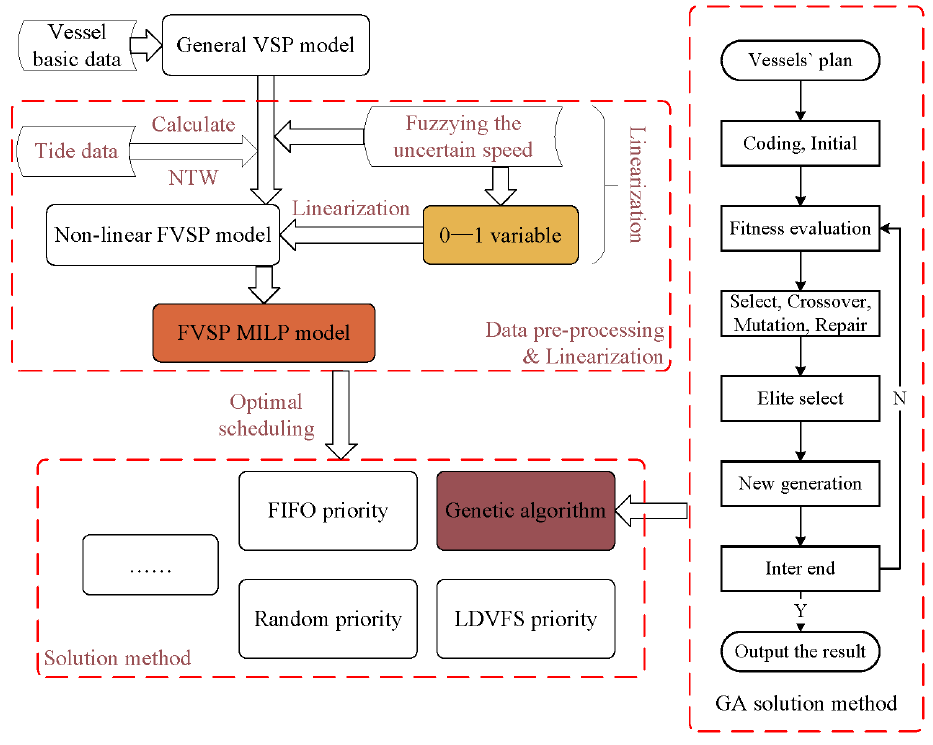
Figure 5. The framework of optimal scheduling where vessel speeds are